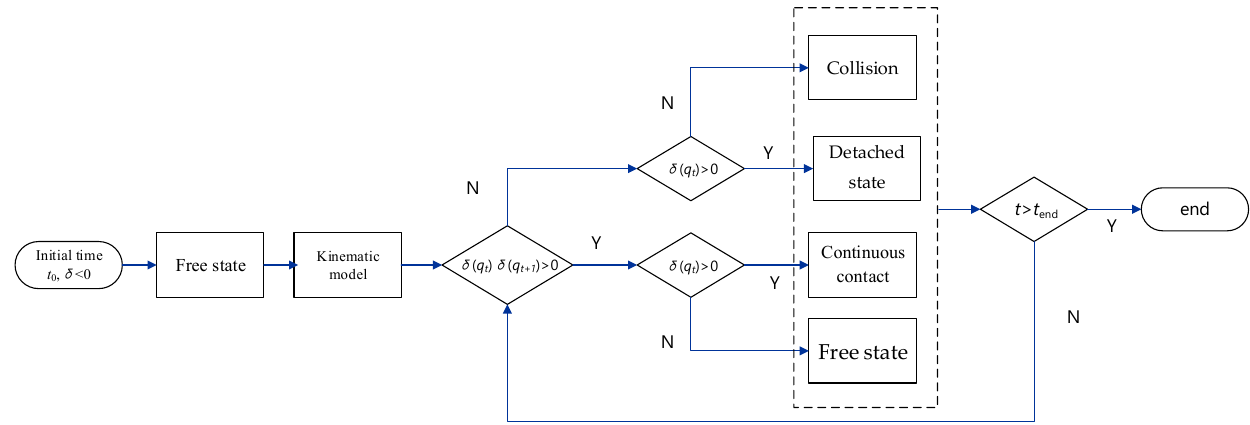
Figure 11. Flow chart of relative motion state judgment.